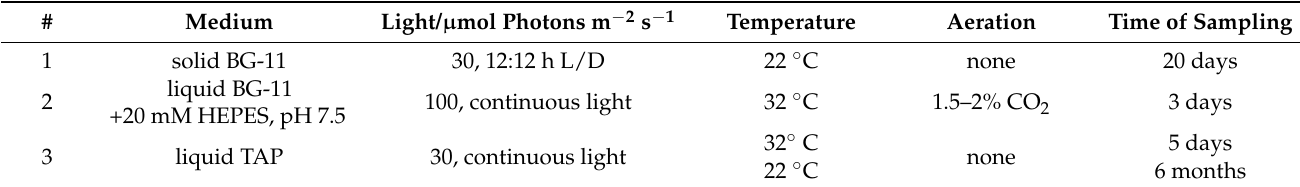
Table 1. Cultivation conditions of the strain IPPAS C-1210 for